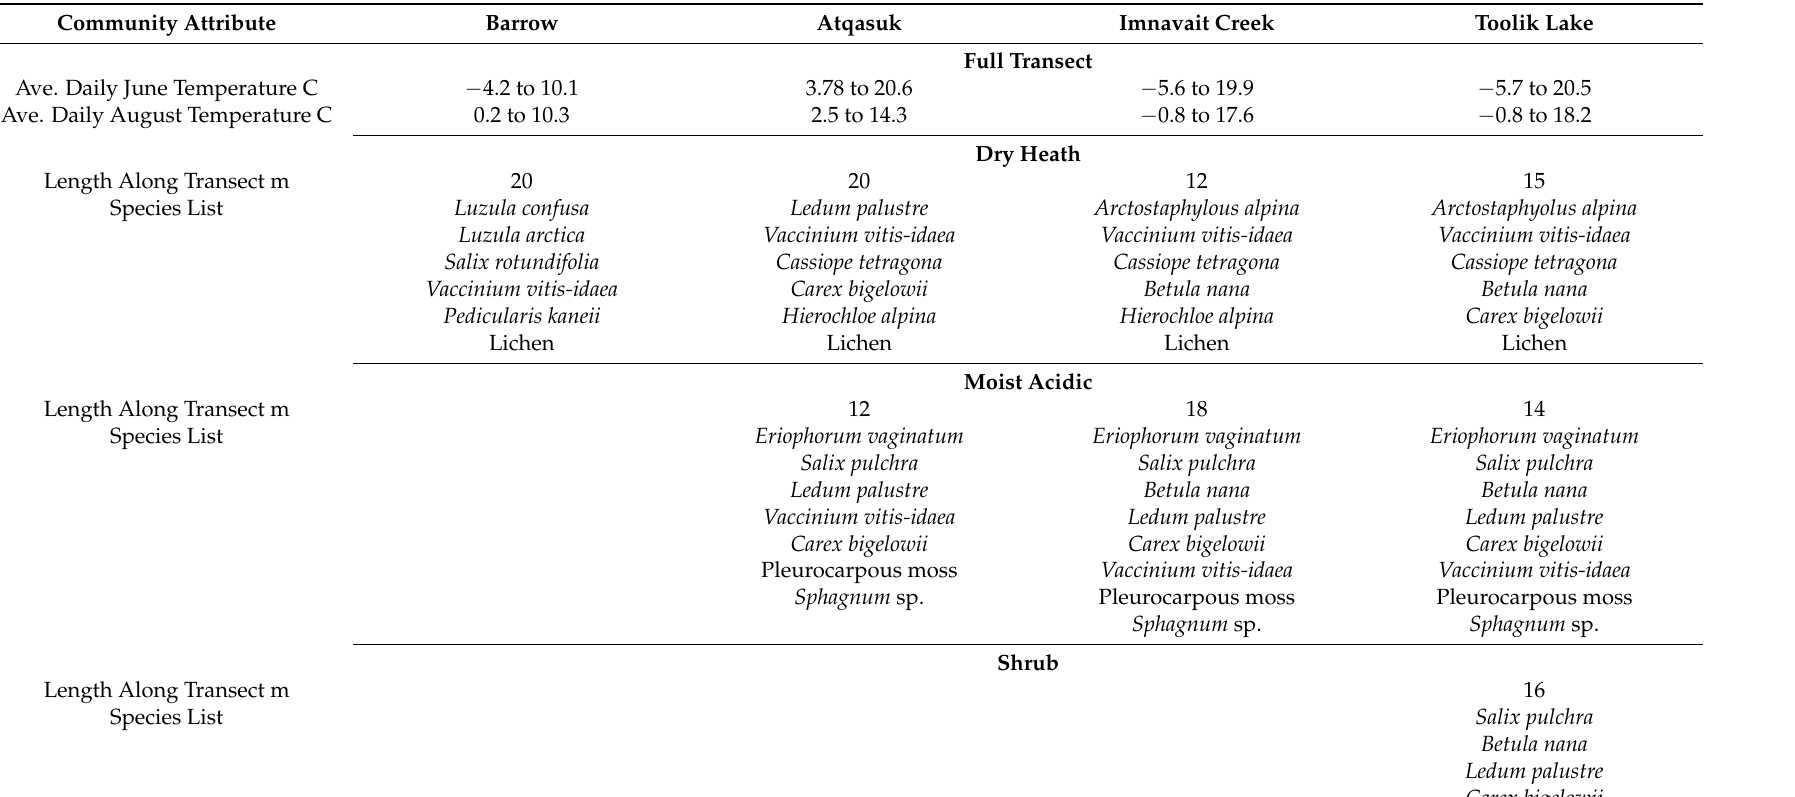
Table 1. Dominant species and habitat types at each of the four MISP